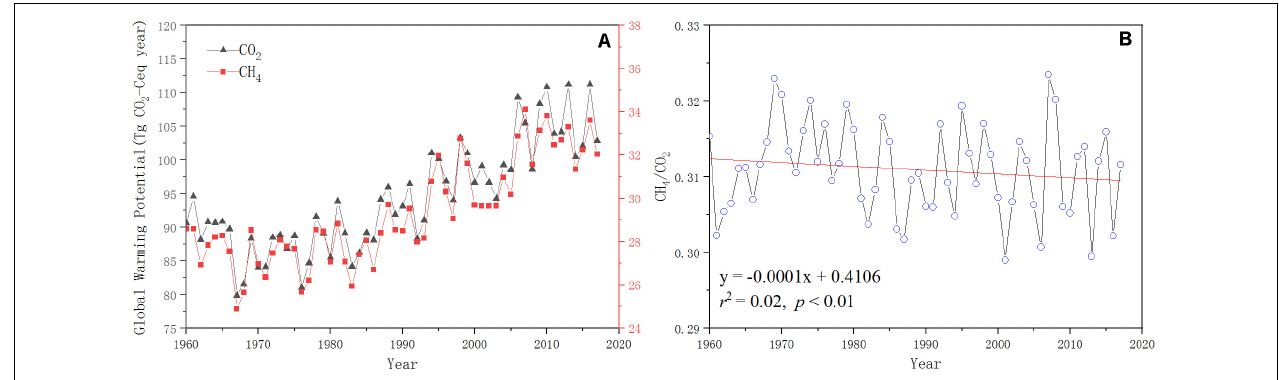
FIGURE 7 | Interannual variation in global warming potential based on CO 2 and CH 4 emissions from the Qinghai-Tibetan Plateau wetlands for the period 1960–2017. (A) CH 4 and CO 2 expressed as CO 2 -C equivalents according to global warming potential (CH 4 :28 and CO 2 :1) (Kandel et al., 2019). (B) Ratio of extrapolated CH 4 –CO 2 emissions over